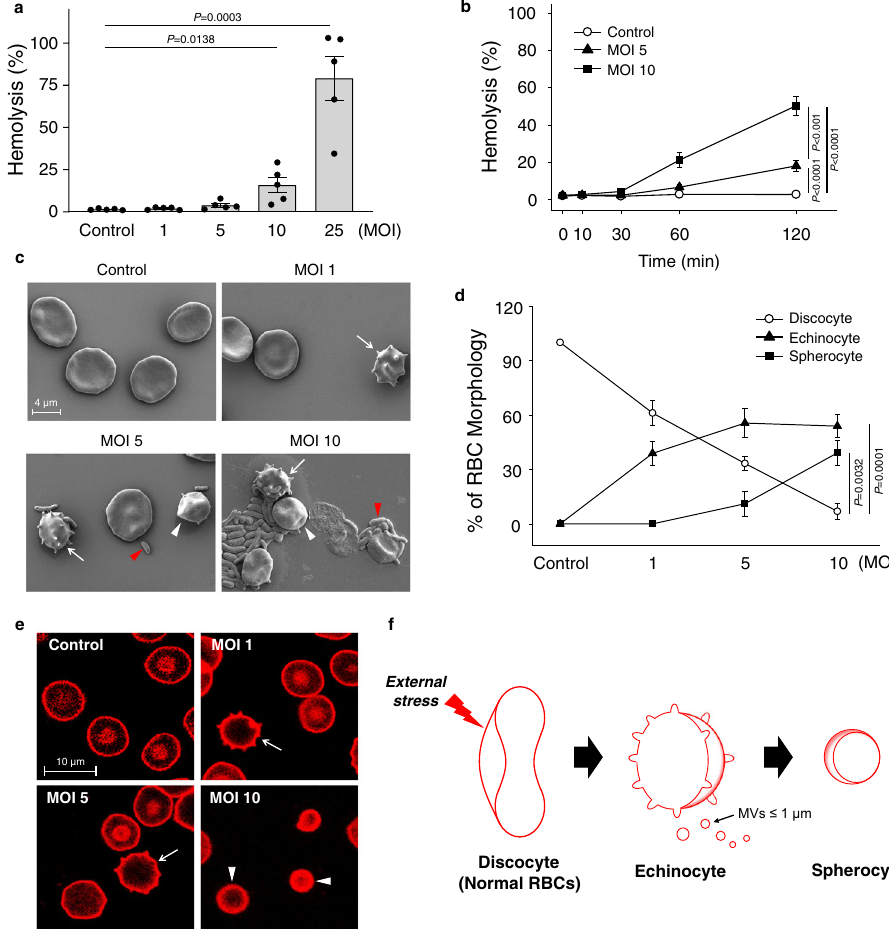
Fig.1|InfectionofhumanRBCswith V.vulni fi cus induceshemolysisandshape change.a , b RBCswereinfectedwith V.vulni fi cus atvariousMOIsandincubated for 1h ( a ) ( n =5, two-tailed Student ’ s t -test) or for different times ( b ) ( n =6, two- indicated. c RBCs were infected with V.vulni fi cus at various MOIs and incubated for1handshapechangeswereanalyzedbySEM.Theredarrowheadindicates V. vulni fi cus ; white arrow, echinocyte; and the white arrowhead, spherocyte. The